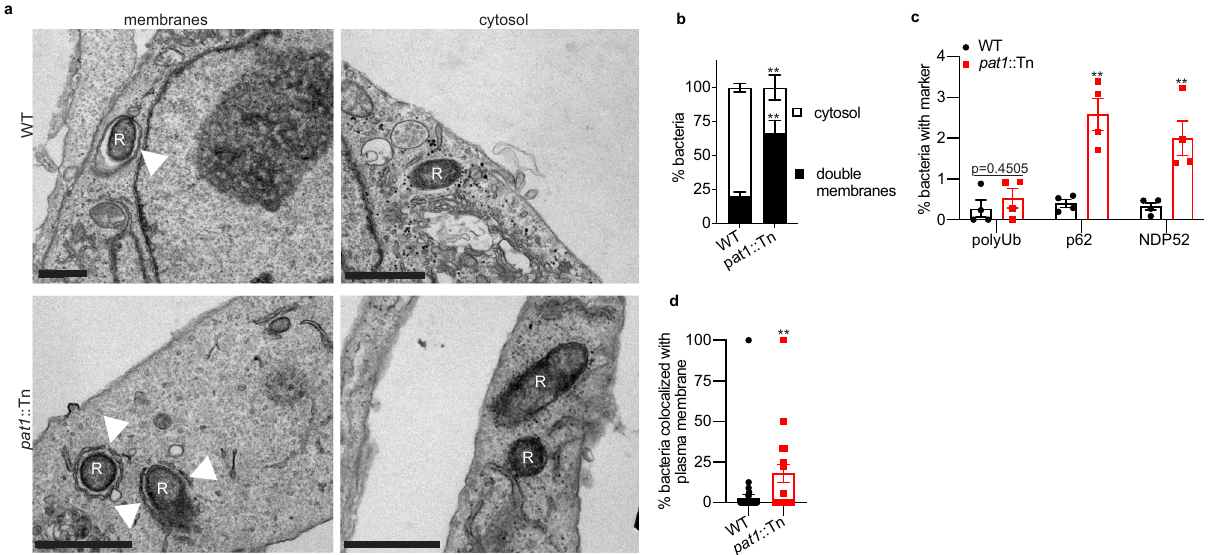
Fig. 7 Pat1 is important for escape from the secondary vacuole. a TEM images of WT and pat1 ::Tn mutant bacteria in HMECs at 48 hpi. “ R ” indicates R. parkeri and arrowheads point membranes surrounding the bacteria. Scale bar 1 µ m. Images represent results from three independent experiments. b Percentage of bacteria in double-membrane compartments or in the cytosol ( n = 3 independent experiments, >300 bacteria quanti fi ed), MOI 0.1. Data are mean ± SEM; ** p = 0.0089 relative to WT (unpaired t -test (two-tailed)). c Percentage of WT and pat1 ::Tn mutant bacteria colocalizing with polyUb, p62, and NDP52 (all n = 4 independent experiments) at 48 hpi in HMECs (>1000 bacteria counted per strain/marker), MOI 0.5. Quanti fi cation was done using fl uorescence microscopy with the same antibodies as Figs. 3a and 4a, b. Data are mean ± SEM; ** p = 0.0017 (p62), p = 0.0067 (NDP52) relative to WT (unpaired t -test (two-tailed)). d Percentage of bacteria in the secondary cell that colocalize with the plasma membrane from the primary cell (measured using fl uorescence microscopy) in mixed cell assays from Fig. 6c at 32 hpi ( n = 3 independent experiments), MOI 4. Data represent individual fi elds imaged that contained bacteria in secondary cells ( n = 46 fi elds for WT, n = 27 fi elds for pat1 ::Tn; bacterial number is in Fig. 6e). Data are mean ± SEM; ** p = 0.0026 (Mann – Whitney (two-tailed)). Source data are provided as a Source Data fi